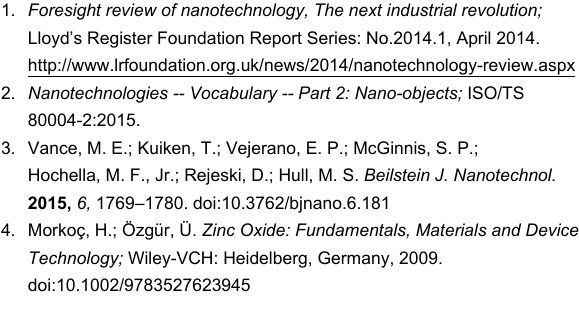
cle sizes calculated based on the specific surface are with an accuracy of 2–6 nm, which confirms